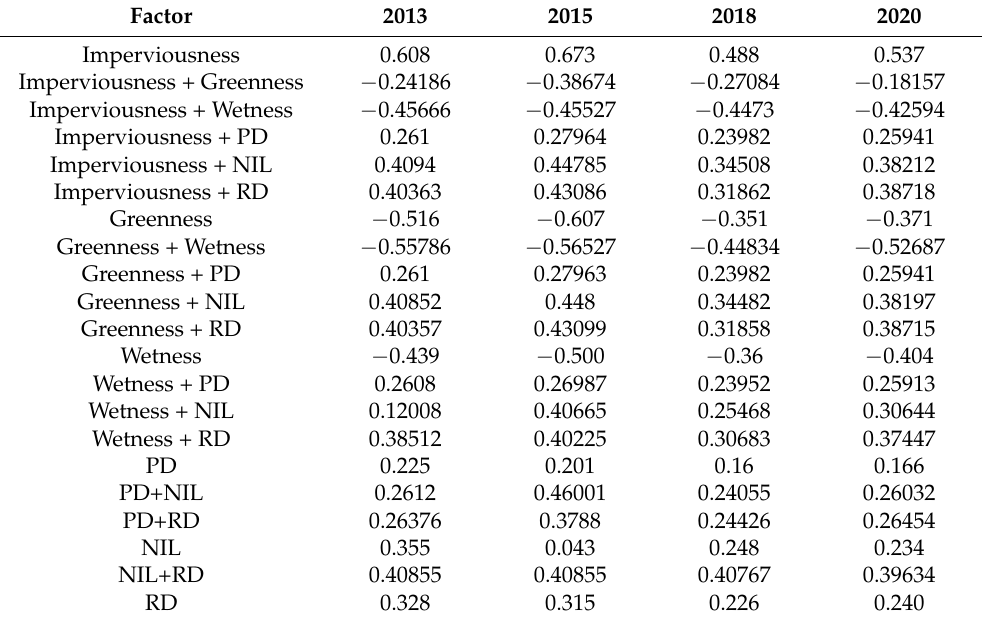
Table 4. Factor superposition